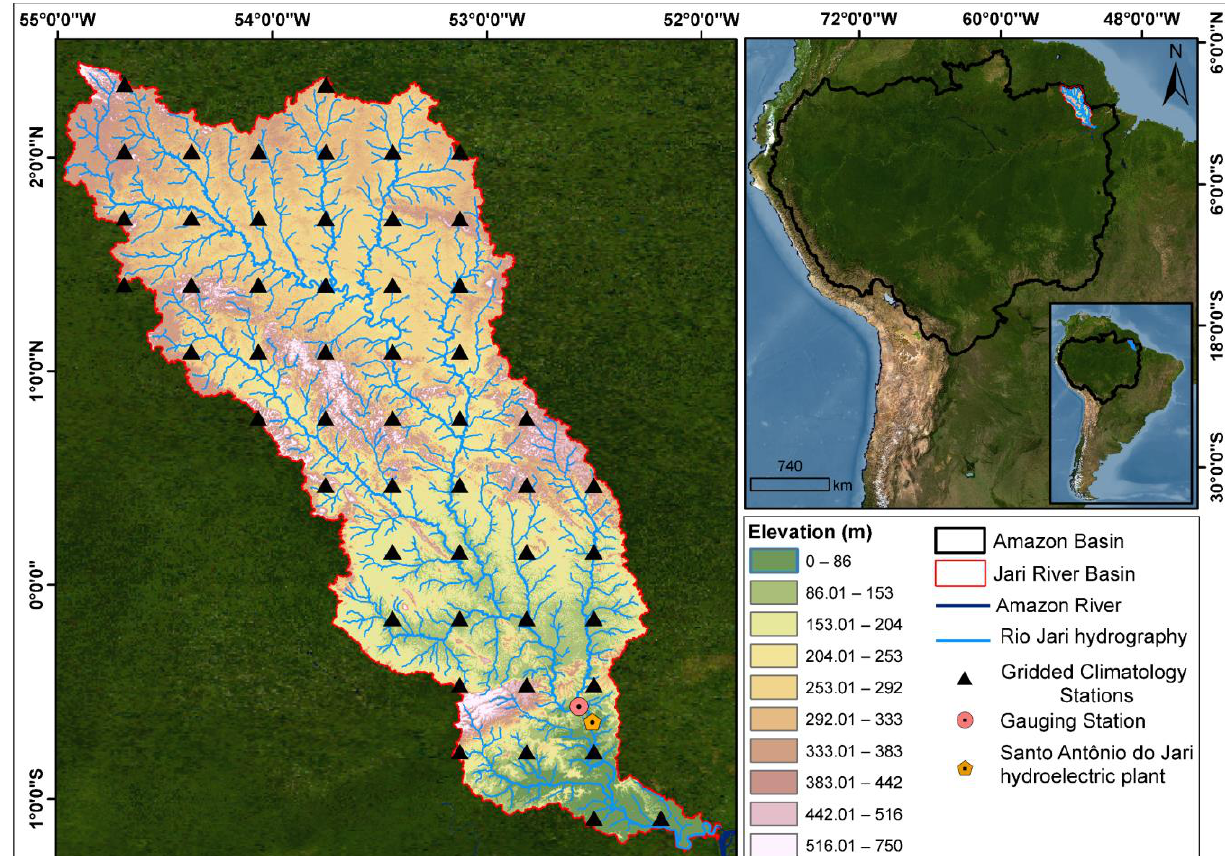
Figure 1. Location and geographic extent of the study area, the Jari River Watershed, within the Amazon River Basin.